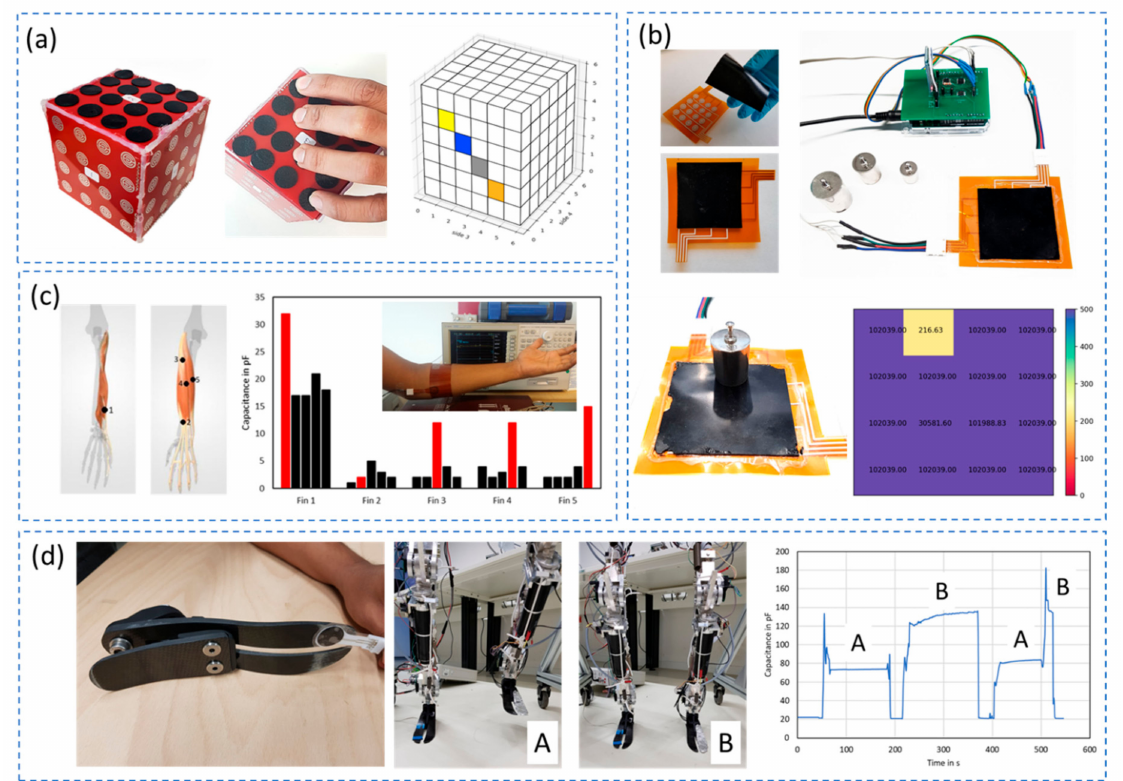
Figure 12. Potential application of nanocomposite pressure sensors: ( a ) touch and grasping, ( b ) matrix for force distribution, ( c ) body attached for muscle movement monitoring and ( d ) robot gait